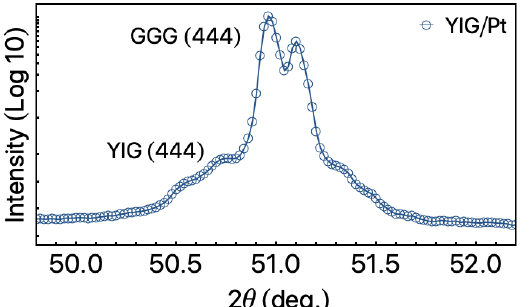
Figure 2. X-ray diffraction result for the YIG/Pt bylayer grown onto a (111) GGG substrate. The peaks are indexed considering the ICSD cards 9237 and 80139 for the GGG and YIG,